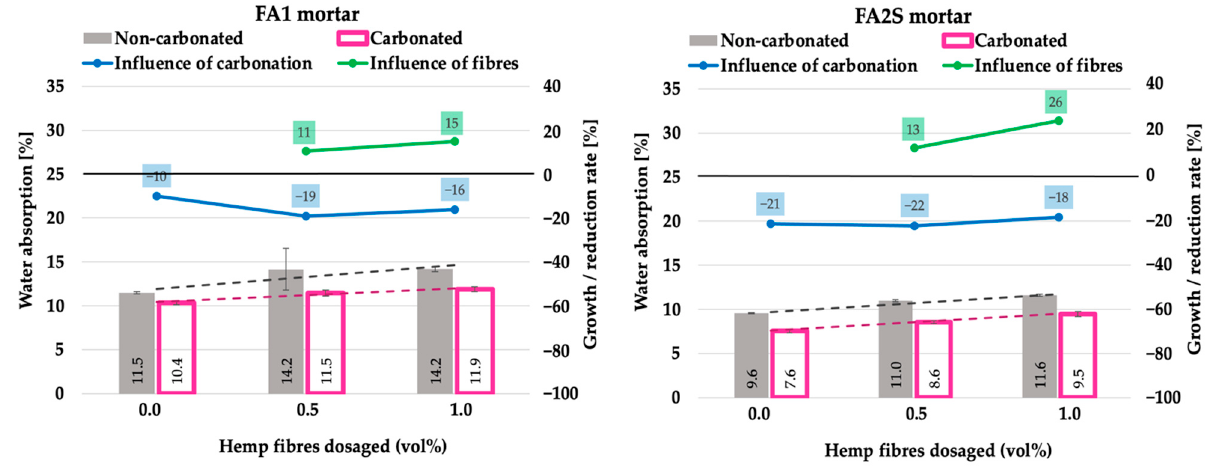
Figure 3. Total water absorption of fly-ash-based (FA1) and fly-ash-and-slag-based (FA2S) mortars prior to [26] and after accelerated carbonation.